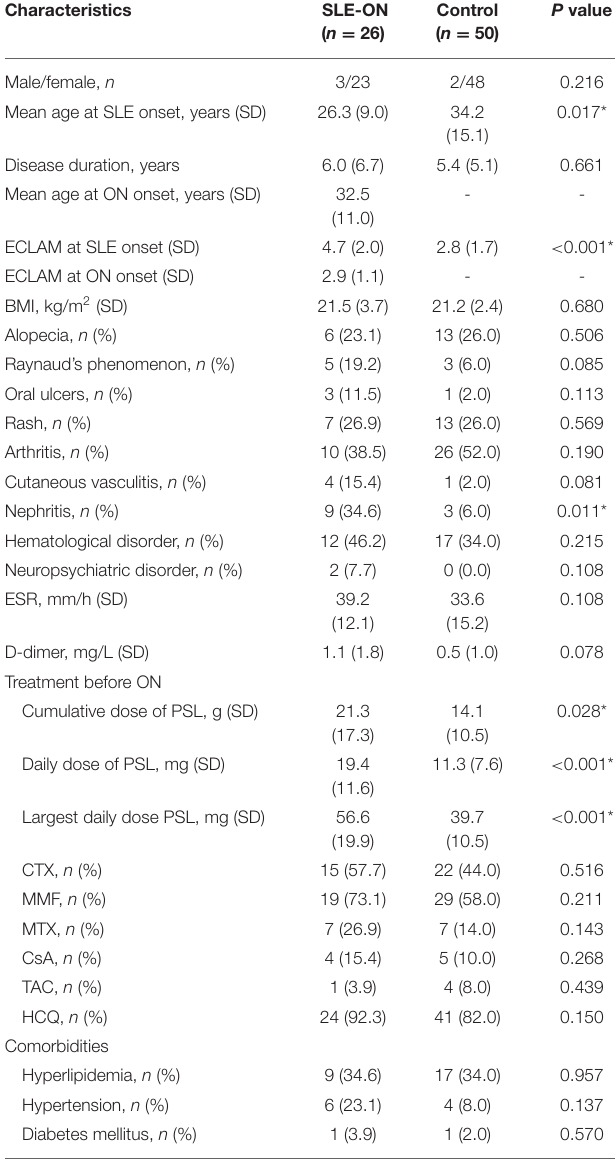
TABLE 1 | Characteristics of patients in the SLE-ON group and control group.